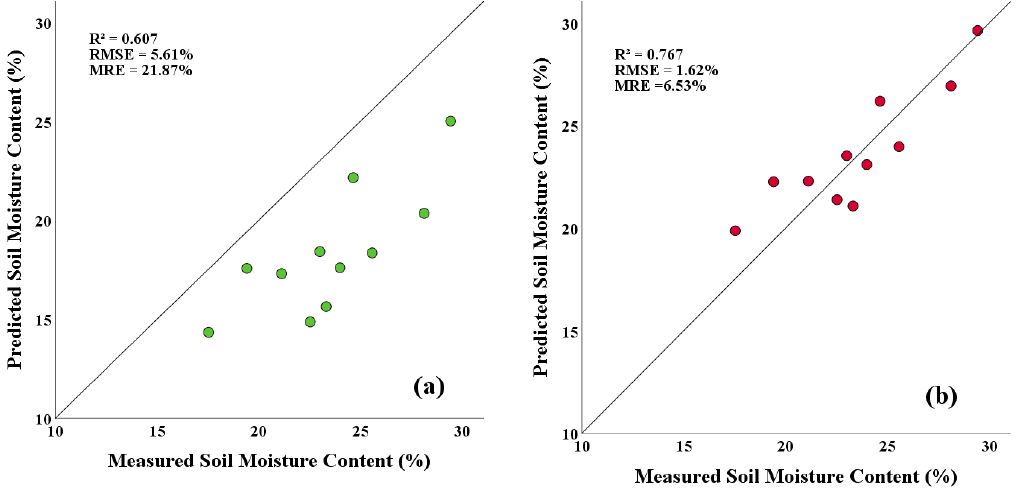
Figure 9. The scattering plot between the estimated and measured SMC g : ( a ) the scattering plot between the measured and predicted SMC g using the original model; ( b ) the scattering plot between the measured and predicted SMC g using the modified model.